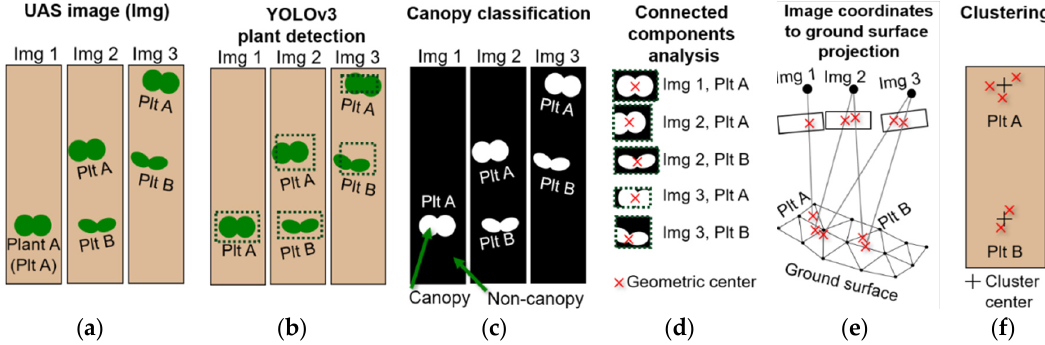
Figure 7. Schematic diagram of overall plant detection procedure: ( a ) UAS data acquisition, ( b ) object detection using YOLOv3, ( c ) binary classification of canopy and non-canopy pixels, ( d ) plant center adjustment by connected components analysis, ( e ) localization of object detection results by UAS photogrammetry, and ( f ) extraction of average plant centers using agglomerative clustering algorithm.